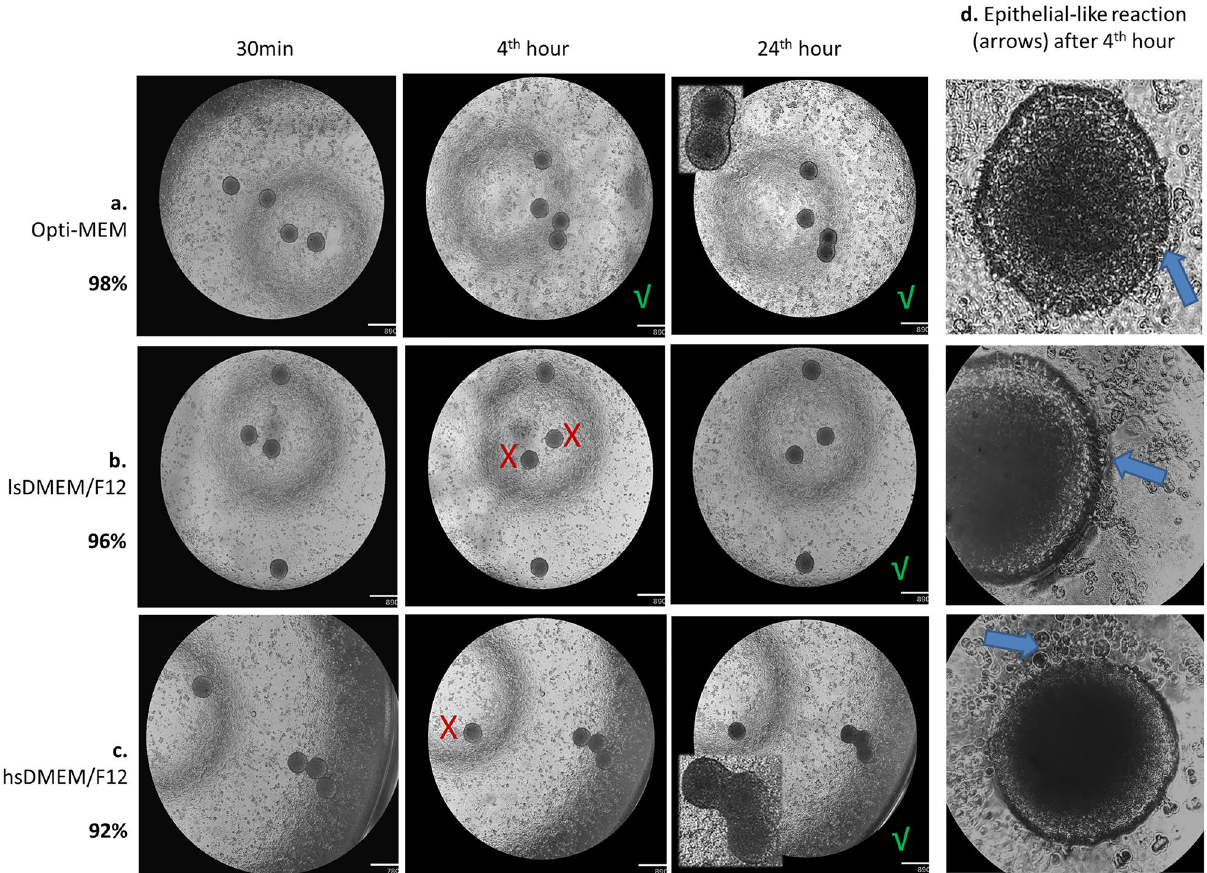
Figure 2. Sw71 spheroids’ attachment capacity. ( a – c ) Representative Sw71 spheroids showing 100% attachment rate 24 h after co-culture with HEC-1A epithelial cells with best results in Opti-MEM followed by lsDMEM/ F12 and hsDMEM/F12 (98%, 96% and 92% respectively). Note that closely disposed spheroids merged as co-incubation advanced (inserts in ( a ) and ( c ), 3rd column). Presented images were taken after shake at 30th min, 4th and 24th hour of co-incubation. ( d ) Representative spheroids in corresponding medium, with focus on the border with signs of epithelial-like reaction (arrows) after the 4 h of co-culture. Imaging: Echo Revolve microscope (Echo, San Diego, USA), magnification 4× ( a – c ), 4x + digital zoom ( d , row 1) and 20× ( d , row 2 and 3). HEC-1A cells confluency was over 95%, estimated by automated live cells imaging system OMNI (CytoSmart technology, The Netherlands). X—unattached spheroid; √—all spheroids were attached at the current time point, bars ( a – c )—890 µm. Seven independent experiments were